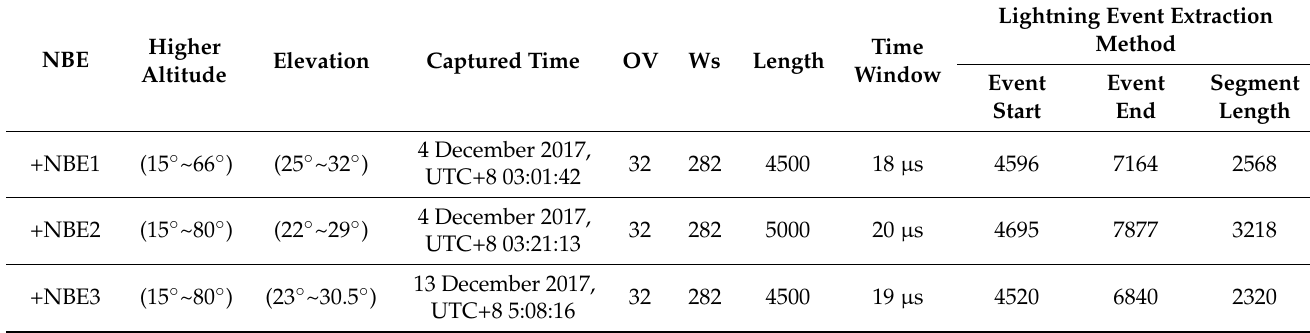
Table 3. Breakdown characteristics for all the NBEs (NBE1, NBE2, and NBE3) of a tuning window size W s = 282.